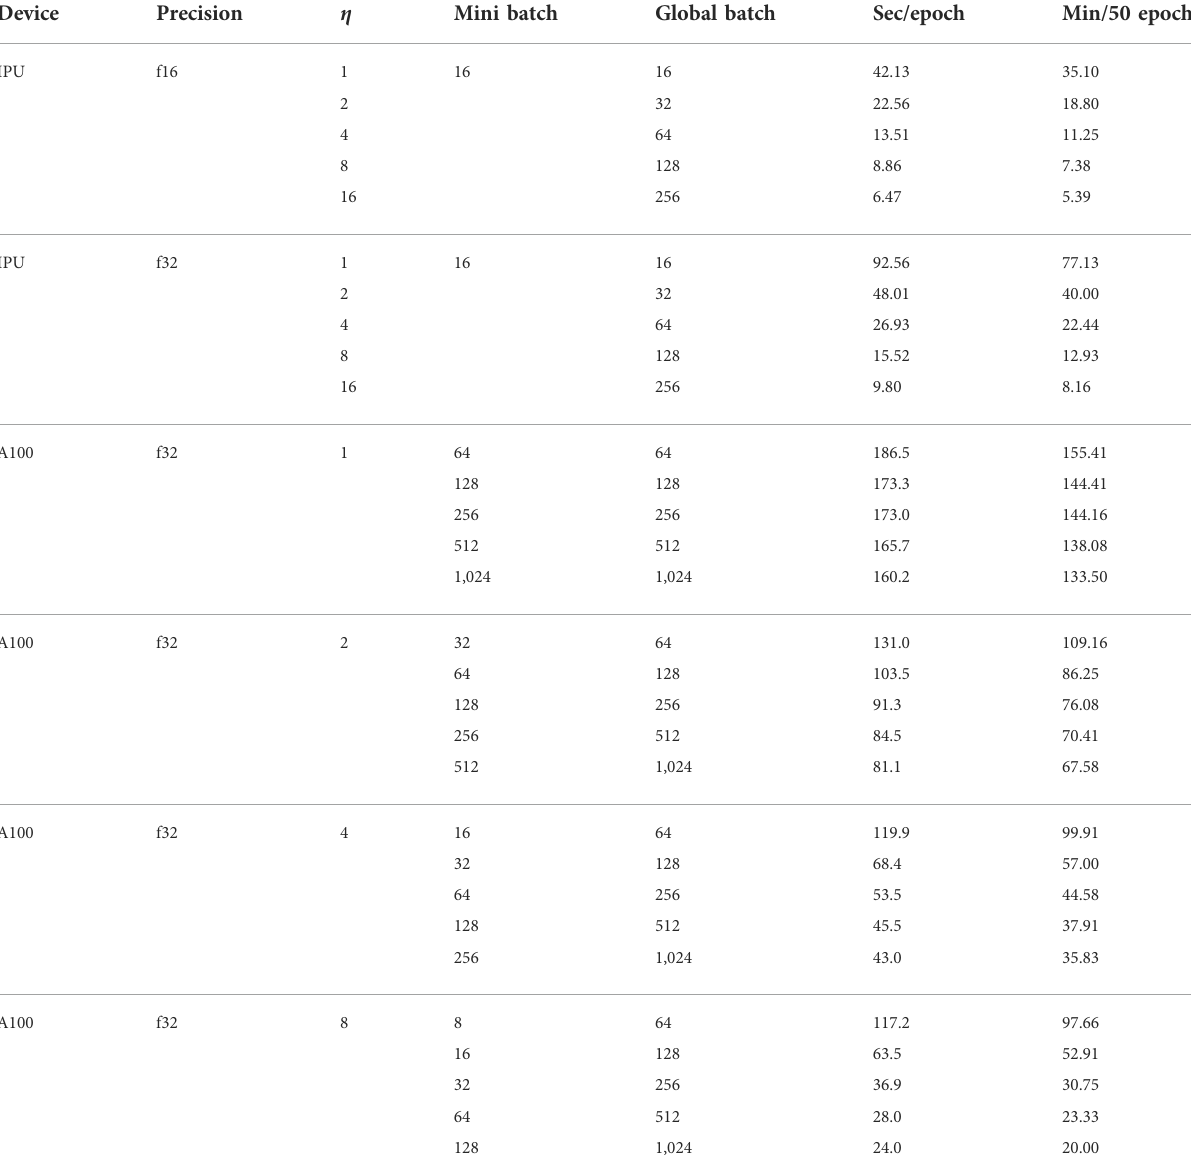
TABLE 4 IPU train time considered in seconds per epoch based on the average results for 50 epochs of 900 k training images per epoch. Device Precision